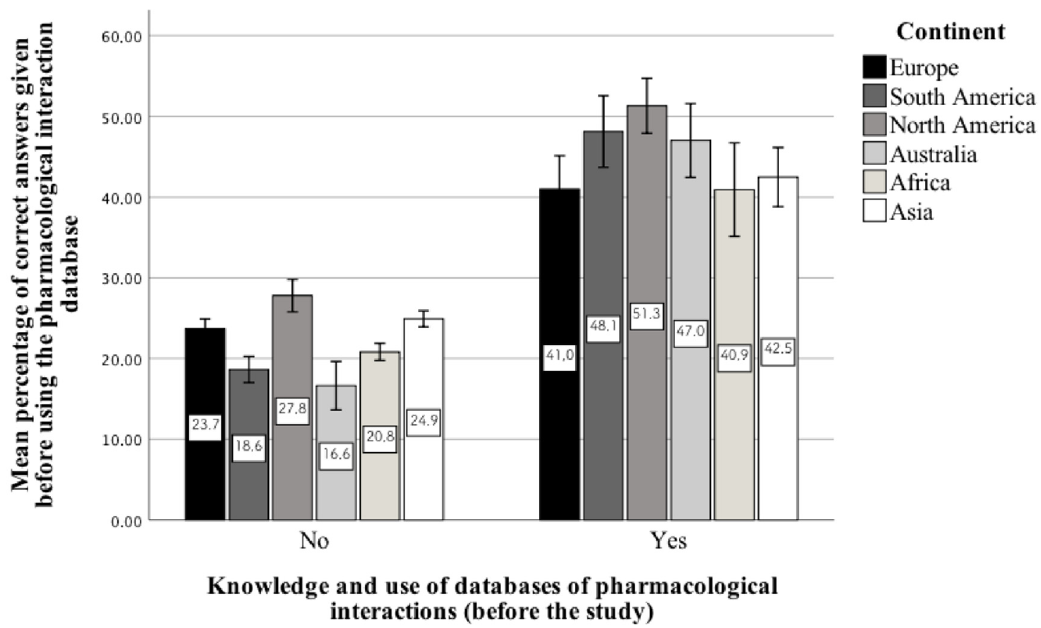
Figure 2. Mean percentage of correct answers given to the questions in the first stage of the study, i.e., in the group of psychiatrists who know and use the pharmacological interaction database on a daily basis or